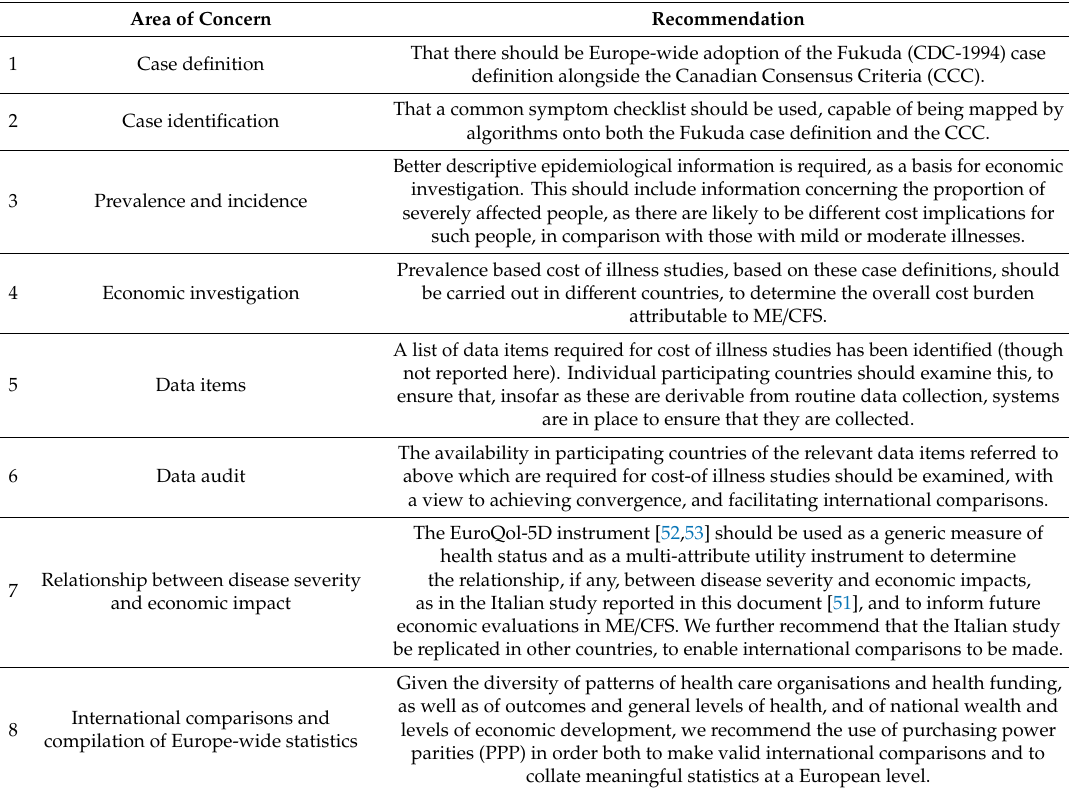
Table 2. Summary of